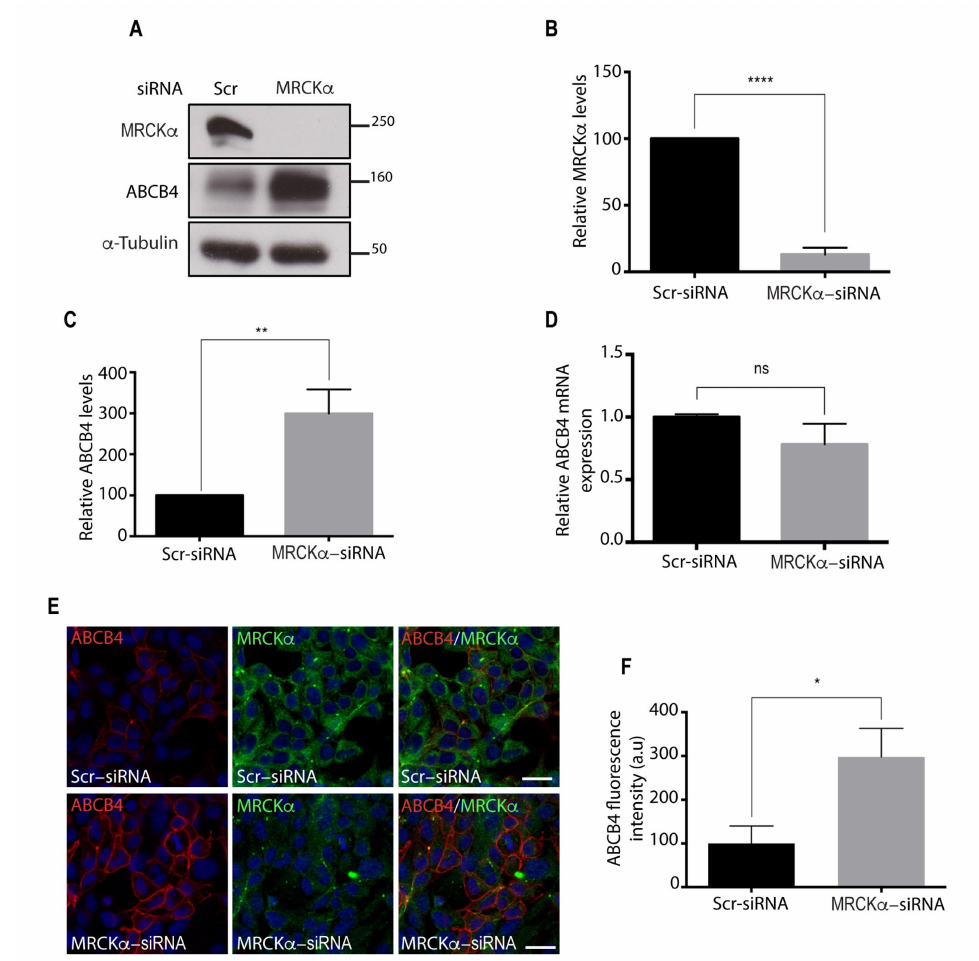
Figure 2. Effect of MRCK α silencing on ABCB4 protein expression. ( A ) HEK-293 cells stably ex- pressing ABCB4 were transfected with scramble control-siRNA (Scr-siRNA) or MRCK α -siRNA. After 72 h of transfection, cells were lysed and analyzed by immunoblotting using anti-MRCK α , anti-ABCB4, and anti-a-tubulin antibodies. Presented data were cropped from the full immunoblots shown in Supplementary Figure S2. ( B ) Amounts of MRCK α were quantified from immunoblots by densitometry to assess the efficiency of the RNA interference. MRCK α levels were expressed as a percentage of total expression in HEK-293 cells transfected with Scr-siRNA. Means ( ± SD) of at least four independent experiments are shown. **** p < 0.0001. ( C ) Amounts of ABCB4 were quantified from immunoblots by densitometry. ABCB4 levels were expressed as a percentage of total expression in HEK-293 cells transfected with Scr-siRNA. Means ( ± SD) of at least four independent experiments are shown. ** p < 0.01. ( D ) RT-qPCR detected unchanged mRNA expression of ABCB4 in HEK-293 cells stably expressing ABCB4 transfected with Scr-siRNA or MRCK α -siRNA; n.s., not significant. ( E ) HEK-293 cells stably expressing ABCB4 were transfected with Scr-siRNA or MRCK α -siRNA. After 72 h of transfection, cells were fixed, permeabilized, and stained with anti-ABCB4 antibody followed by anti-MRCK α antibody, and then incubated with Alexa-Fluor-594- and 488-conjugated secondary antibodies and visualized by confocal microscopy. Nuclei were stained with DRAQ 5 (Blue). Bars: 10 mm. ( F ) The amount of ABCB4 was quantified in Scr-siRNA- or MRCK α -siRNA-transfected cells using ImageJ 1.41 Software. Means ( ± SD) of two independent experiments are shown. * p < 0.05; a.u., arbitrary